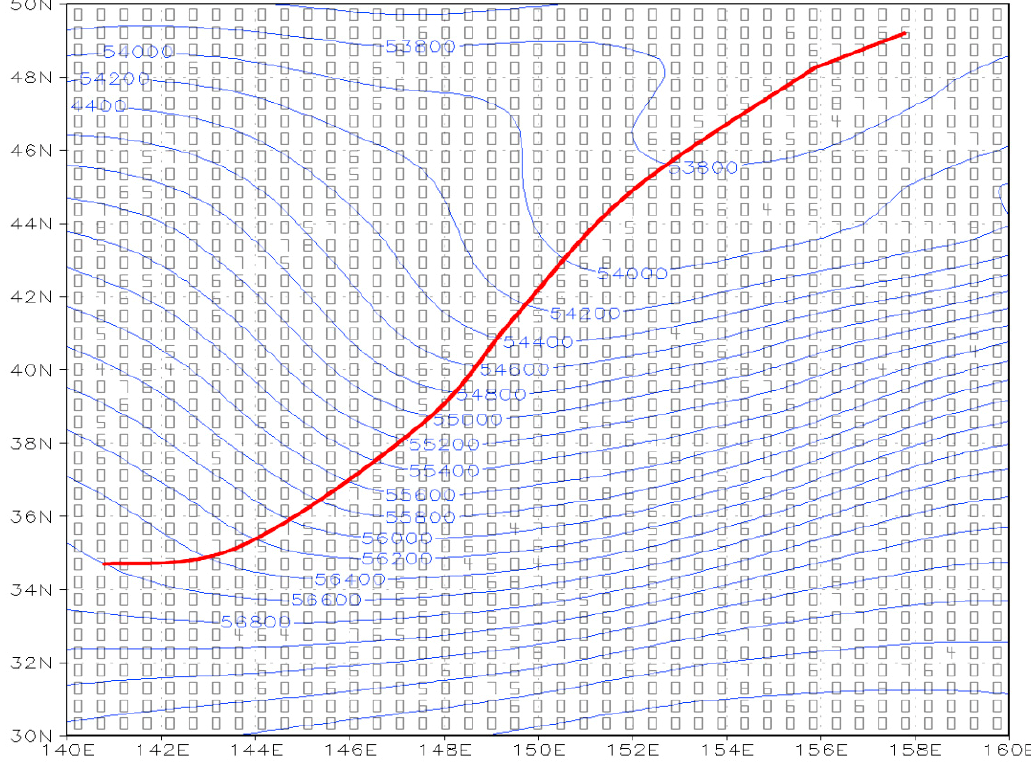
Figure 5. Post-processing result of trough line from 2200 UTC on 8 October 2013.